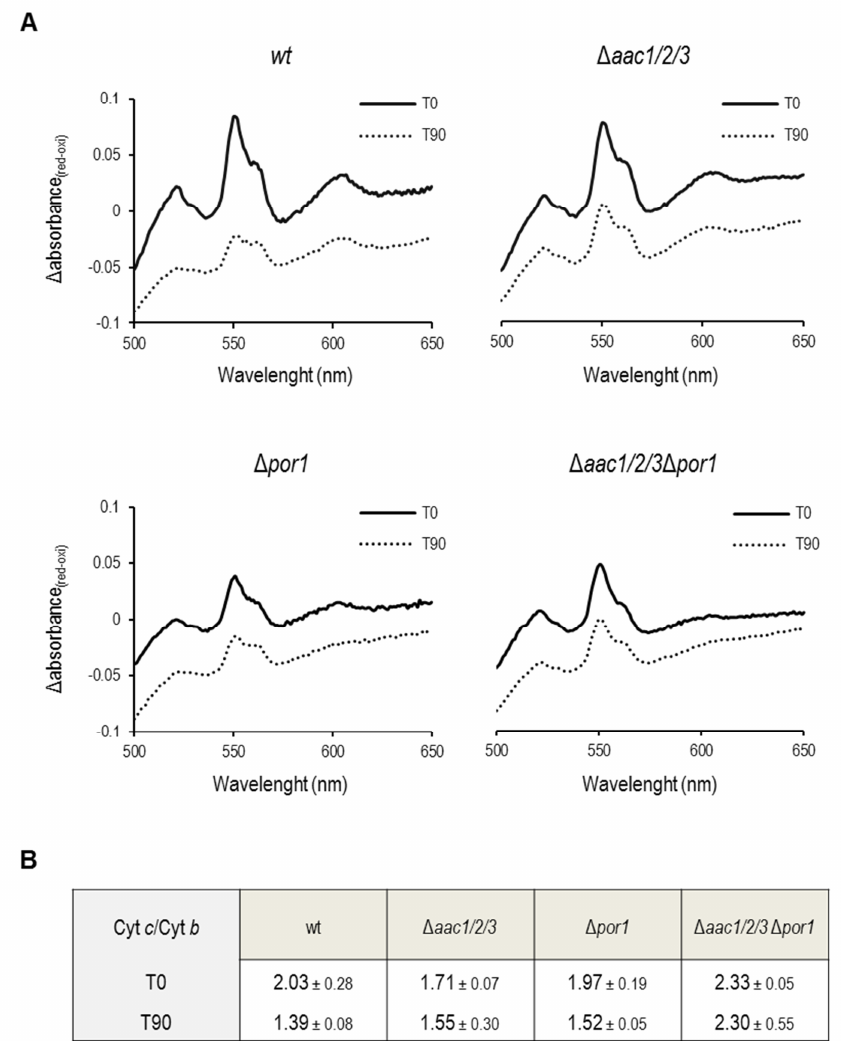
FIGURE 2: Mitochondria lacking the AAC proteins retain most of their cyt c after acetic acid treatment. (A) Cells were pre- cultured in YPD, and then grown O.N. in YPGal until an OD 640nm of 1.5-2.0 was reached, before adding acetic acid. Redox difference spectra of mitochondria isolat- ed from wt , Δ aac1/2/3 , Δ por1 and Δ aac1/2/3 Δ por1 control (full lines) or acetic acid-treated cells (dotted lines) are shown. Each graphic corresponds to one representative experiment from each tested strain. Peaks at 500 nm represent the amount of cytochromes c + c1 while peaks at 561 nm represent the content of cytochrome b . (B) The corresponding cyt c /cyt b ratios estimated for wt , Δ aac1/2/3 , Δ por1 and Δ aac1/2/3 Δ por1 mitochondria extracted from control and acetic acid-treated (180 mM, 90 minutes) cells are represented in the lower table. Data represent mean ± SD of at least 3 independent